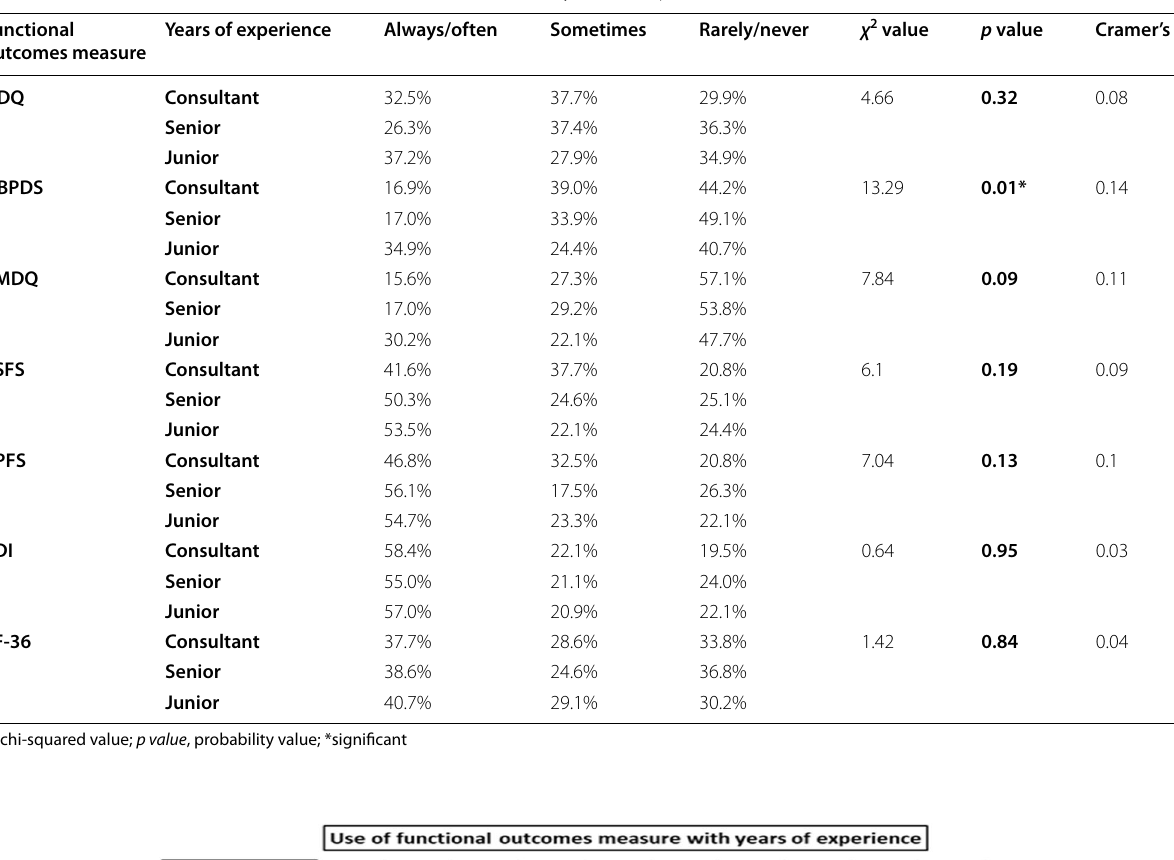
Table 3 Association of use of functional outcome measure with years of experience Functional Years of experience outcomes measure